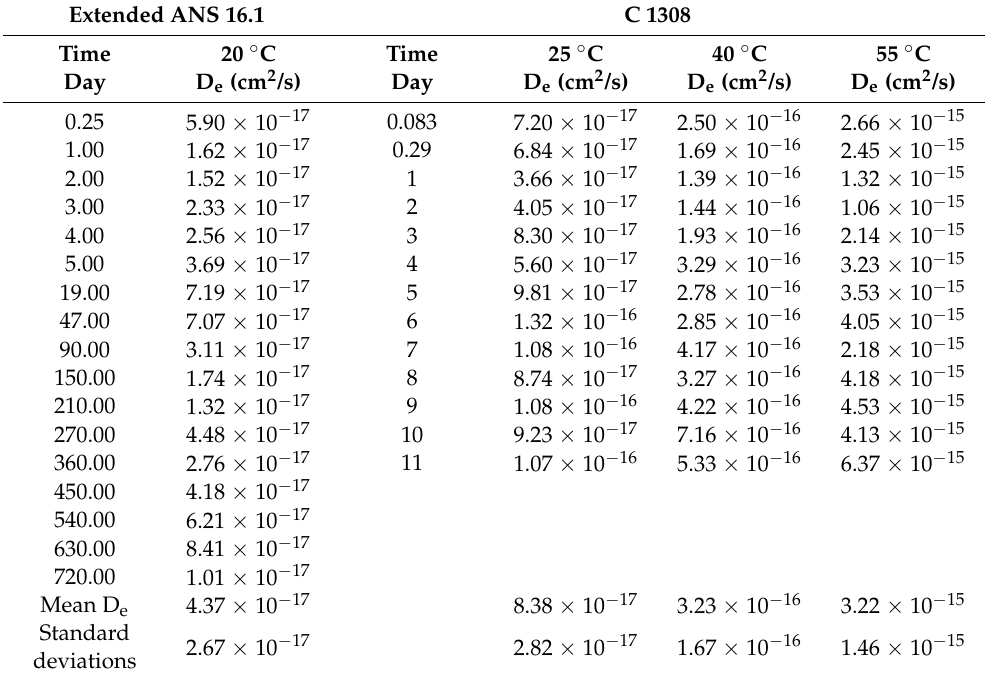
Figure 5. Effective diffusion coefficients of leaching tests at different temperatures. Table 3. Variation in effective diffusion coefficient at different temperatures.